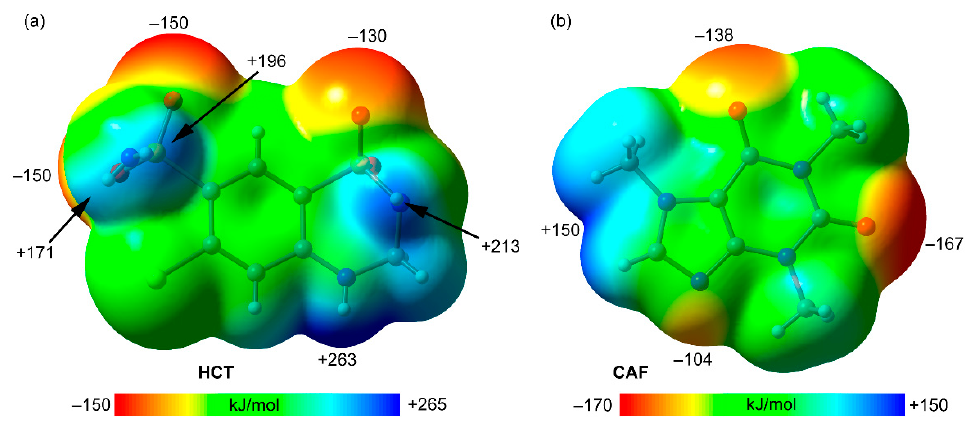
Figure 9. Molecular electrostatic potential (MEP) surface (isosurface 0.001 a.u.) of HCT ( a ) and CAF ( b ) at the PBE0-D3/def2-TZVP level of theory. The values at selected points of the surfaces are given in kJ/mol.